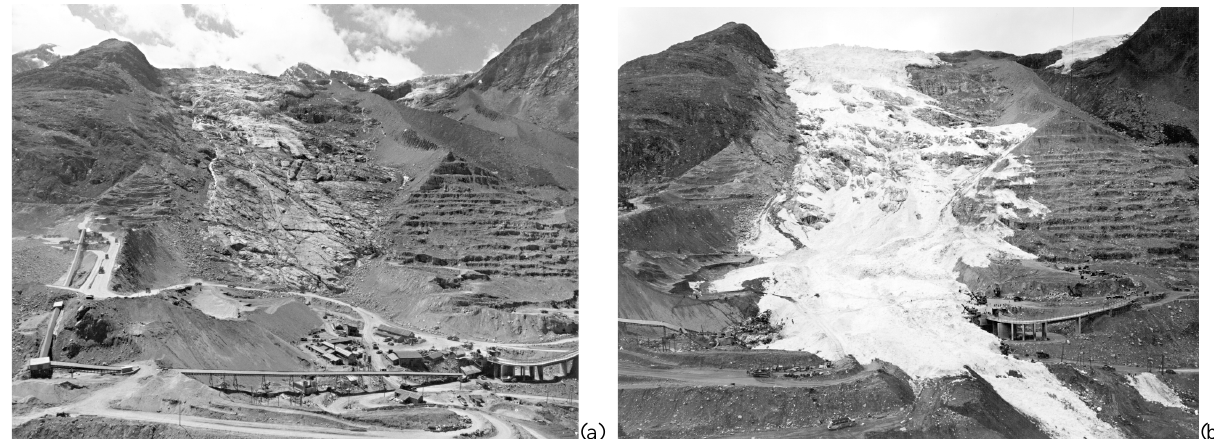
Fig. 4. Allalingletscher (a) before and (b) after the Mattmark catastrophe, 30 August 1965: Breaking-off of 2millionm 3 of ice (P. Kasser, Photo Archive VAW).